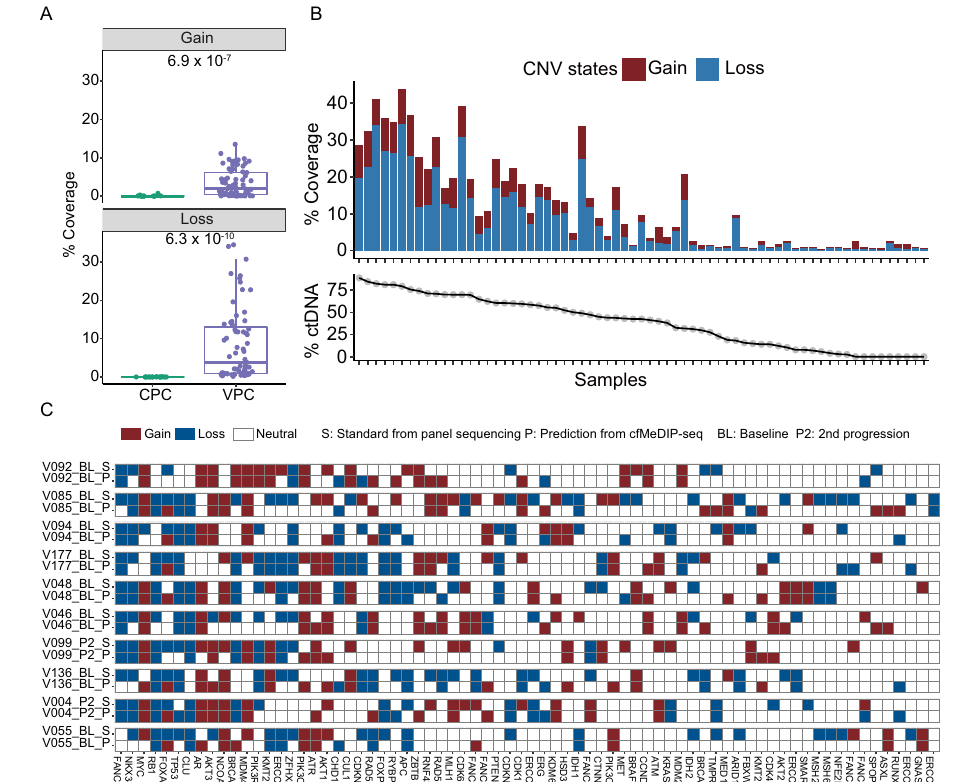
Fig. 5 | Prediction of sample CNA using cfDNA methylome. A Predicted CNA coverage in localized samples from the CPC and mCRPC samples from the VPC cohorts. Two-sided Mann-Whitney U test was used to calculate pairwise P values. Boxplotsrepresentmedianvaluesand0.25and0.75quantiles.Whiskersrepresent 1.5× IQR. X =30, and 67 independent experiments for the CPC and VPC cohorts,